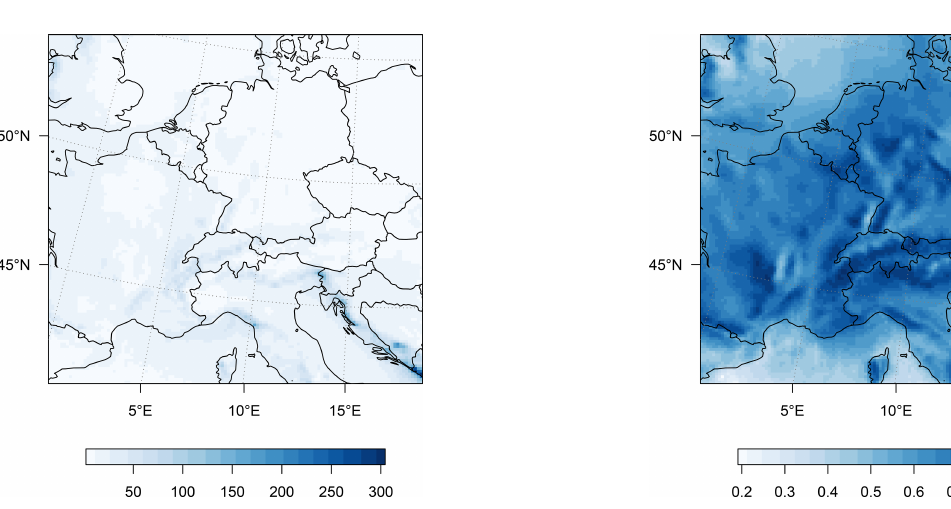
Figure 4. MSE (based on precipitation data in mmd − 1 ) for each grid cell for the precipitation predictions.